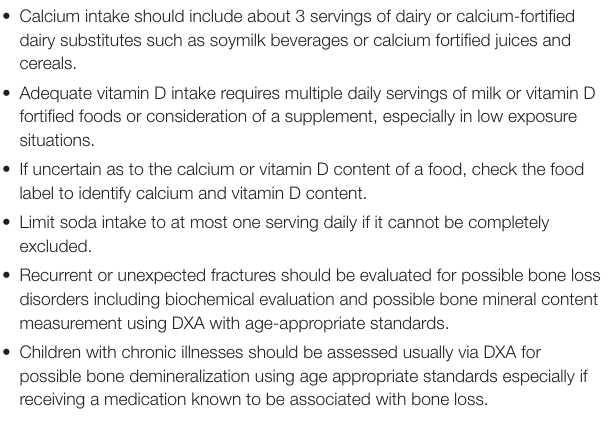
TABLE 2 | Key messages for families regarding bone mineral nutrition in school age children (1,